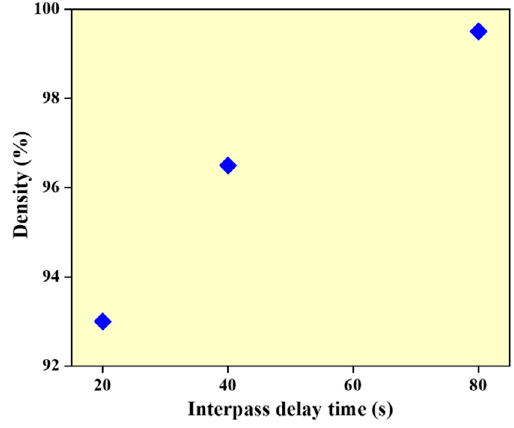
Figure 3. Plot showing the density values of the samples with different thermal delay.